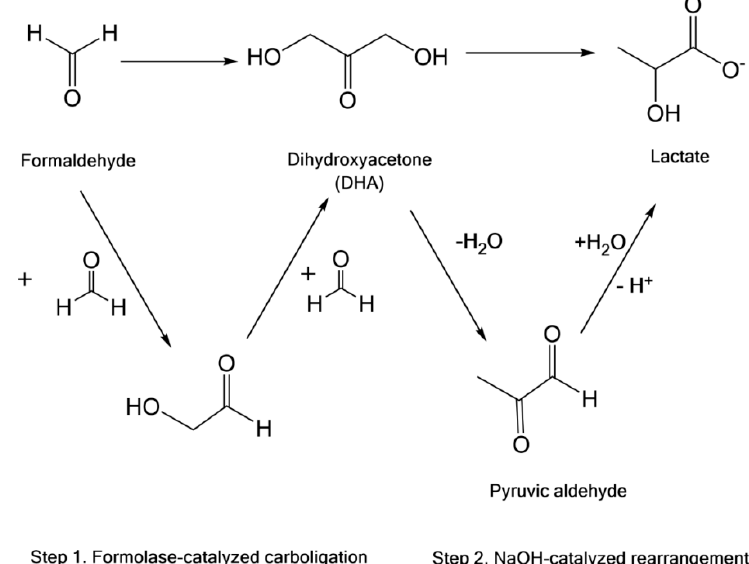
Figure 6. General two-step synthesis of lactate from formaldehyde.